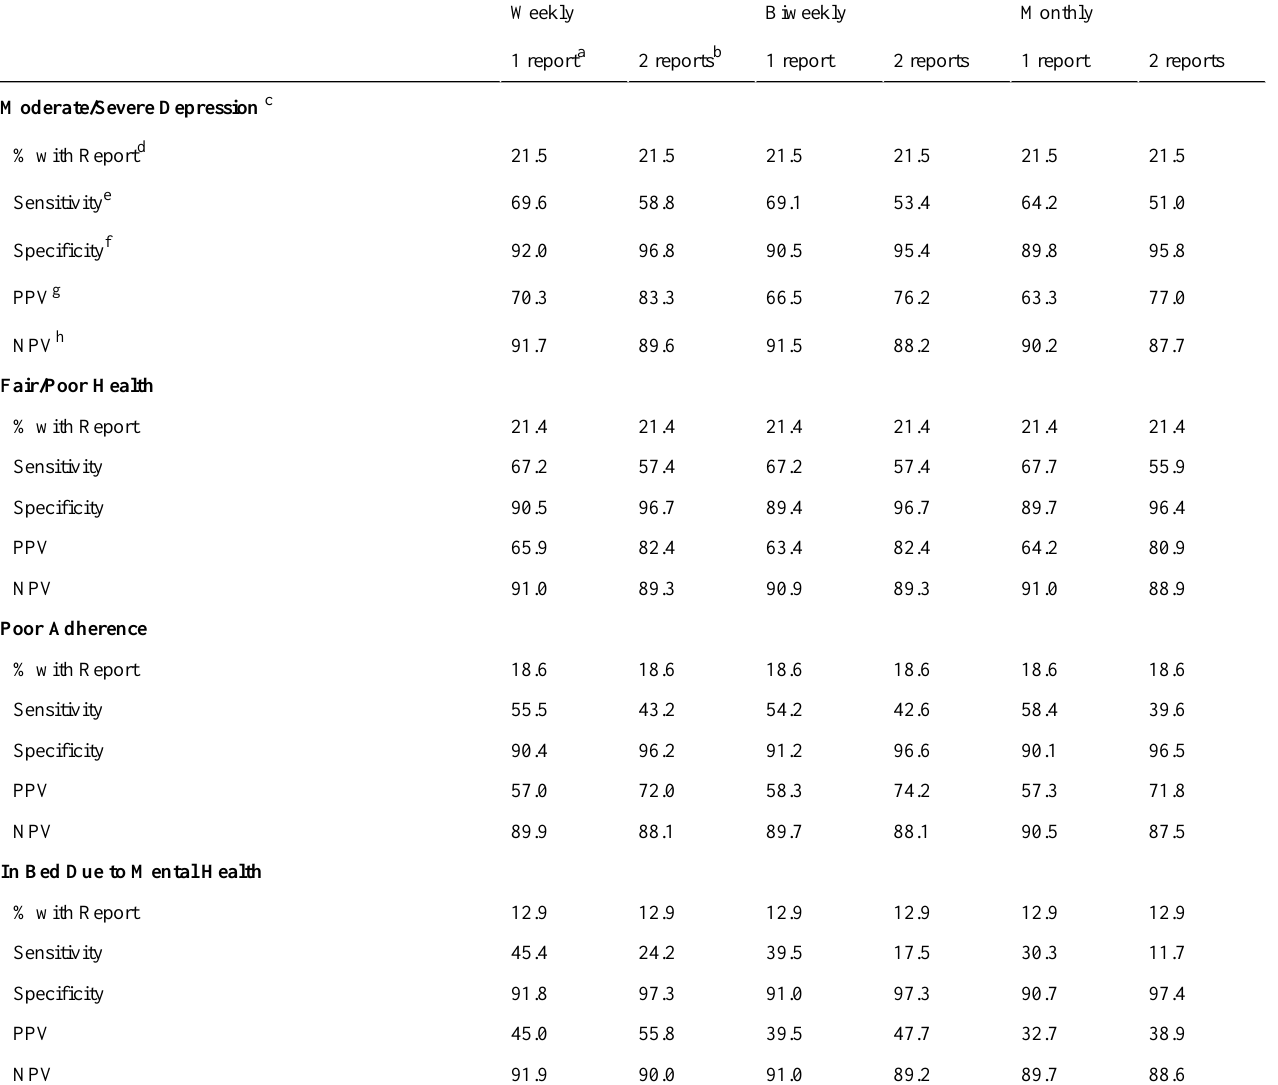
Table 2. Variation in problem reports by the number and frequency of prior reports of the same